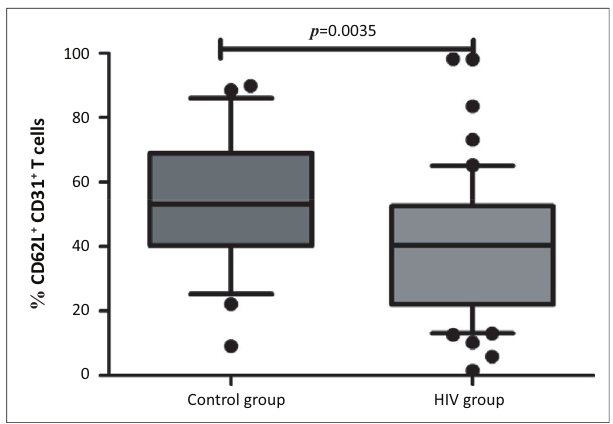
FIGURE 1: Baseline levels of per cent of CD4+/CD45RA+/CD62L+/CD31+ T-cells in HIV-positive versus control groups.